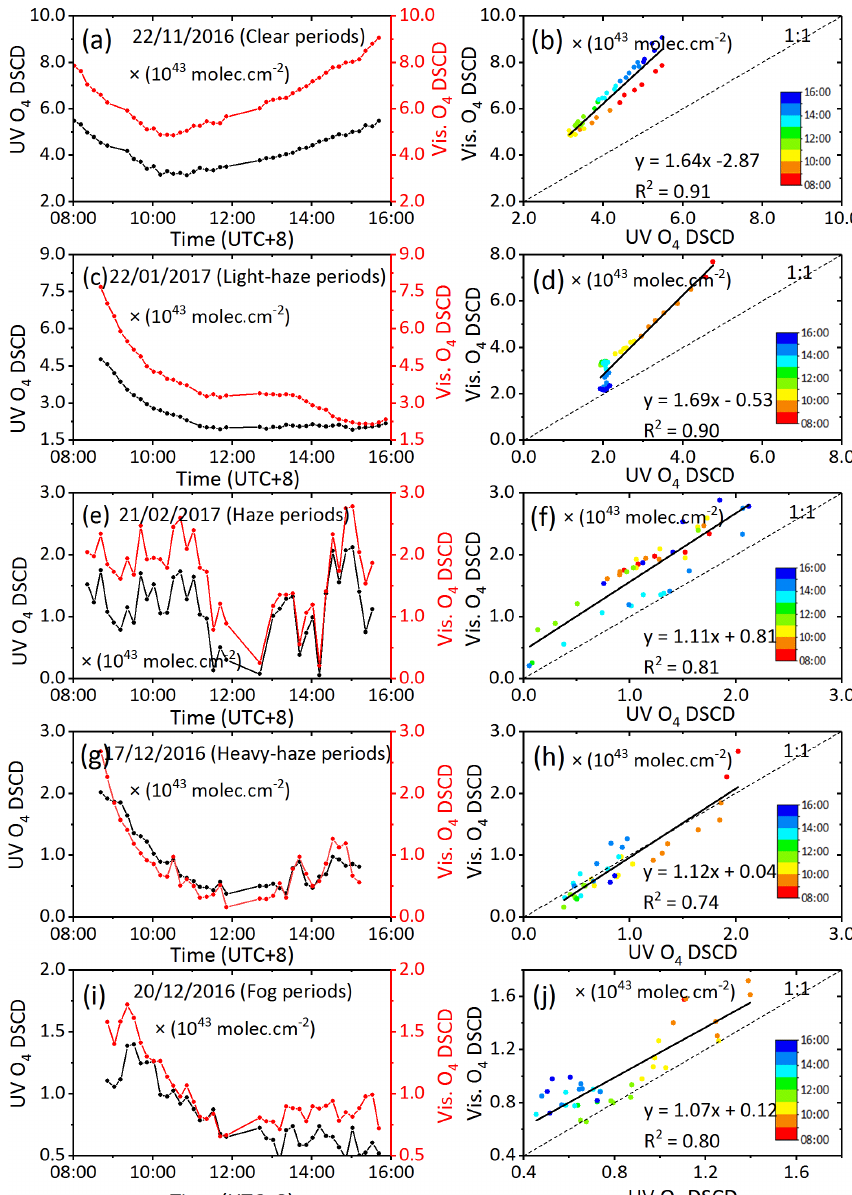
Figure 3. Diurnal variation and correlation analysis of O 4 DSCDs at 360.8 and 477.1nm under different weather conditions: (a) and (b) clear day, (c) and (d) light-haze day, (e) and (f) haze day, (g) and (h) heavy-haze day, (i) and (j) fog day. The color bar represents the time